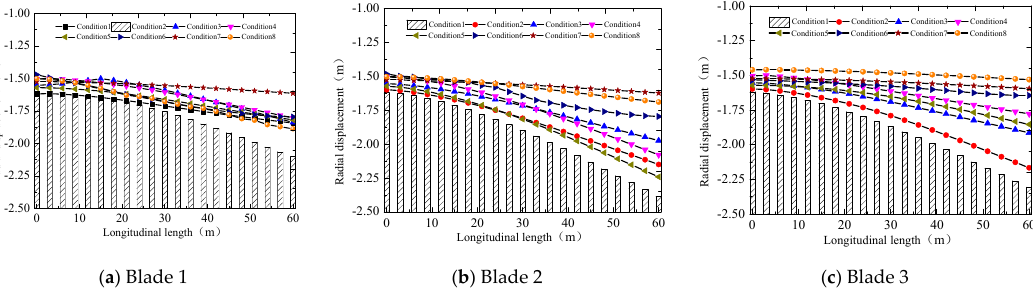
Figure 26. Distributions of mean downwind displacement of blades under different conditions.